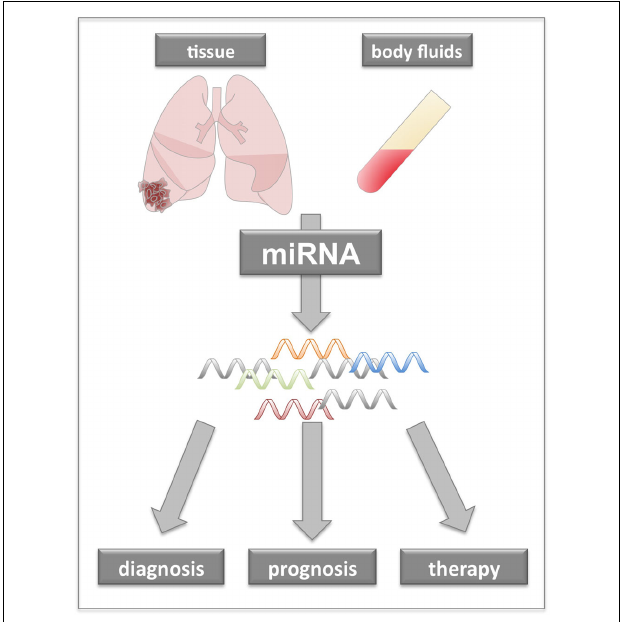
FIGURE 1 |The impact of miRNA research on clinical oncology. Alterations in miRNA expression are associated with pathophysiological changes in cancer cells. As miRNA signatures from cancer tissue or patients’ body fluids differ from those of healthy individuals miRNA signatures may likely to contribute to improved early diagnosis or patients’ prognosis.Through altered expression single miRNAs may act as oncogene or they may loose their tumor suppressor properties.Those miRNAs could be utilized for anti-cancer